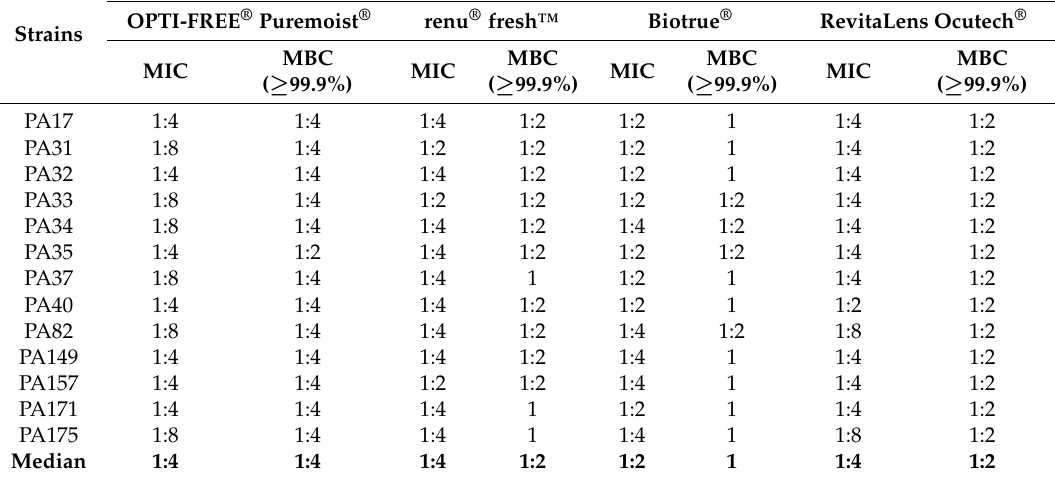
Table 2. Minimum inhibitory concentration and minimum bactericidal concentration of multipurpose disinfectant